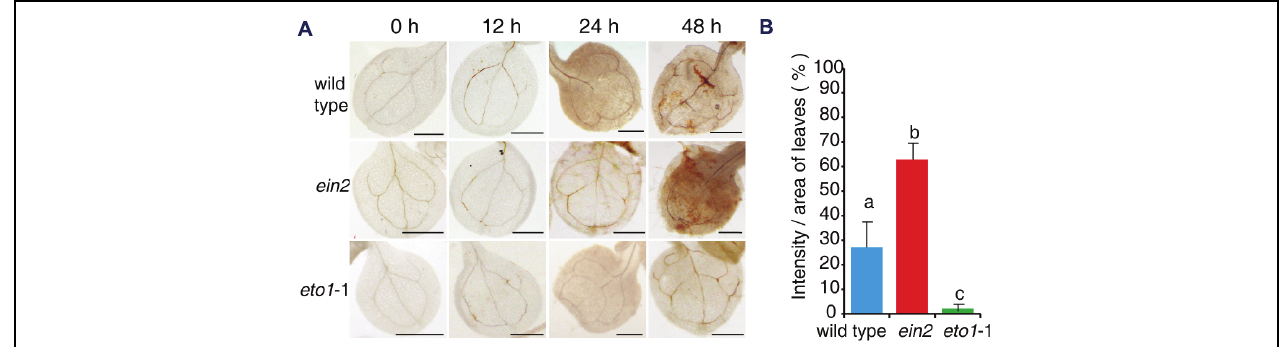
FIGURE 3 | Histochemical detection of H 2 O 2 in leaves of mutants after treatment with FB1. (A) Representative leaves of wild-type, ein2 , and eto1 -1 seedlings stained with DAB after treatment with 0.5 µ M FB1 for the indicated times. (B) Quantification of DAB staining in leaves treated with FB1 for 48 h. H 2 O 2 deposits were quantified by measuring the intensity of DAB staining per unit area of leaves, using Image J. At least six leaves per genotype were analyzed for each time point and the experiments were repeated three times with similar results. Values represent means ± SD ( n = 6). Data sets marked with different letters indicate significant differences assessed by Student–Newman–Keul test ( P < 0.05).